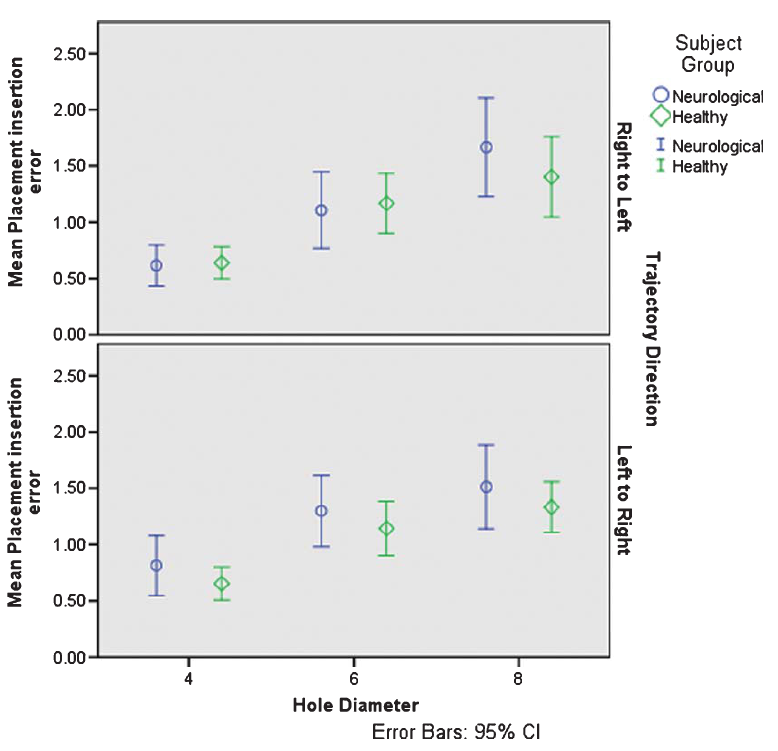
Fig. 10. Comparing insertion error for R2L and L2R half cycles and subject